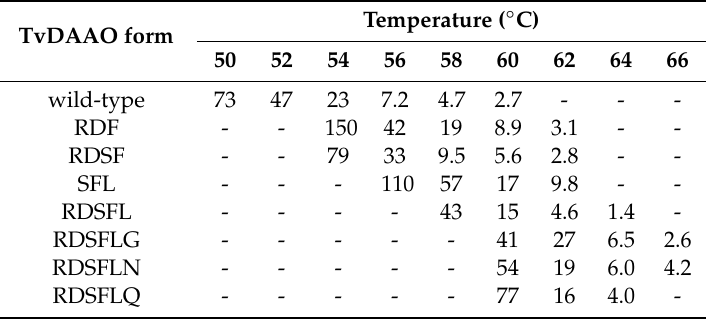
Table 2. Half-life times τ 1 / 2 (min) of wild-type TvDAAO and TvDAAO mutants (0.1 M potassium phosphate bu ff er pH